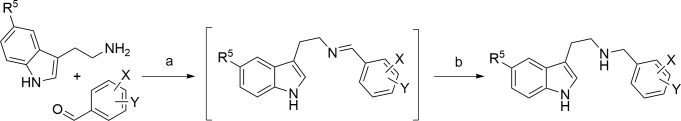
Synthesis of N-(substituted)benzyltryptamines.a: MeOH, r.t., overnight; b: NaBH4 in small portions, r.t.